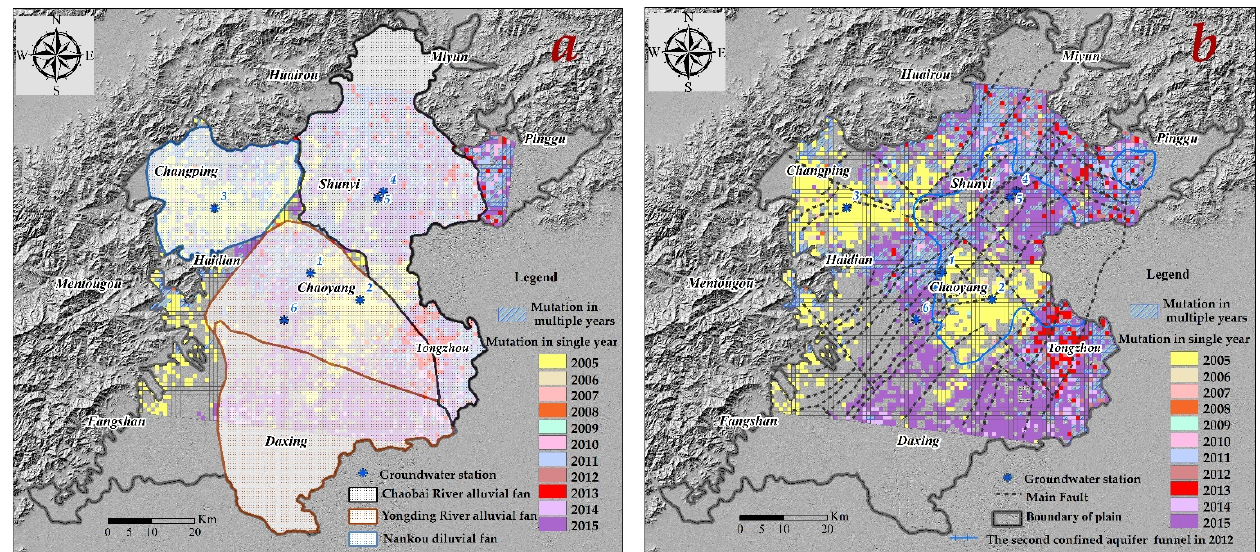
Figure 5. The information of subsidence mutation in the Beijing Plain (2004–2015). ( a ) shows the distribution of alluvial and diluvial fans in the Beijing Plain, and ( b ) shows the distribution of major faults in the Beijing Plain.